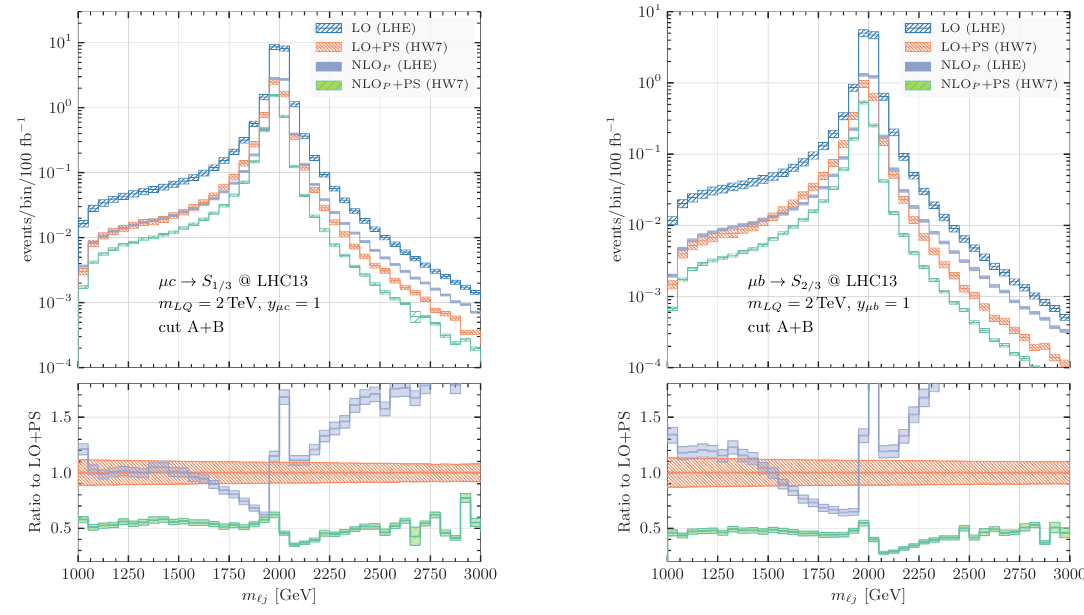
Figure 7 . As in figure 6 for the combination cut A+B . The left (right) panel displays the result for a leptoquark m = 2 TeV, charge Q = ± 1 / 3 ( ± 2 / 3 ) and which couples only to muons and LQ LQ charm (bottom)